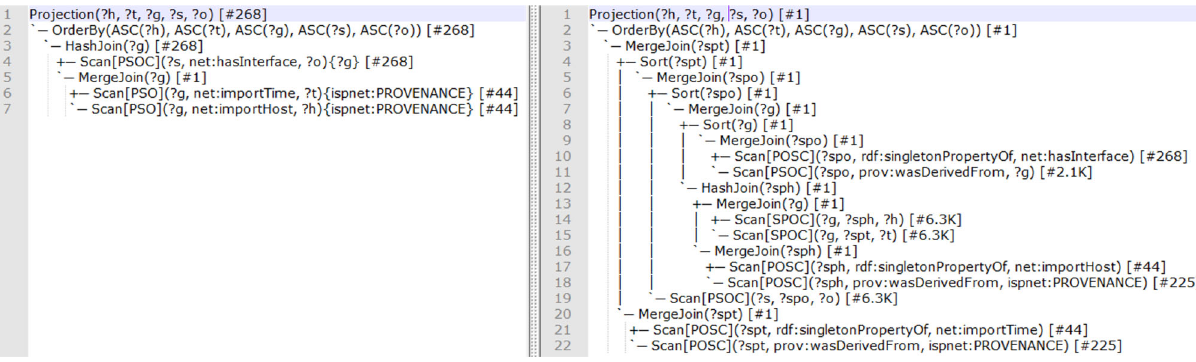
Fig. 3 Query structure analysis to identify pipeline breakers in the case of GraphSource (left) and singleton property